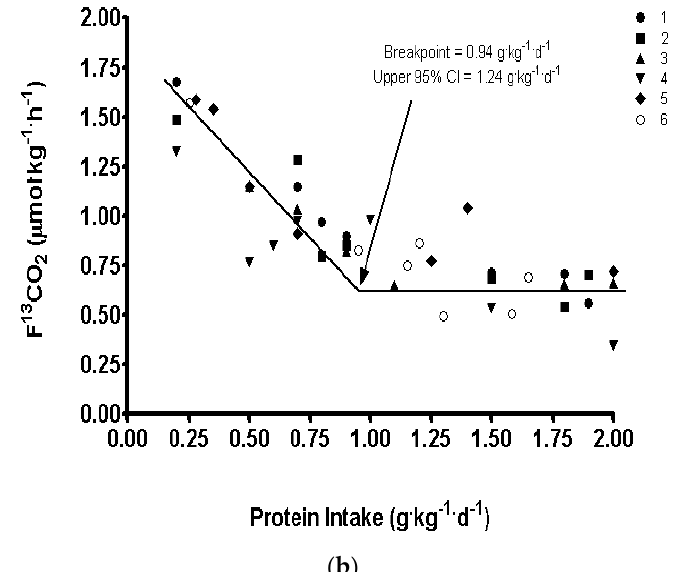
Figure 2. Protein requirements in healthy elderly determined using the IAAO method ( a ) Women >65 years, n = 12, each subject participated in a minimum of two test intakes for a total of 82 studies, mean (population safe intakes) = 0.96 (1.29) g/kg/day; ( b ) Men >65 years, n = 6, each subject participated in seven test intakes for a total of 42 studies, mean (population safe intakes = 0.94 (1.24) g/kg/day.